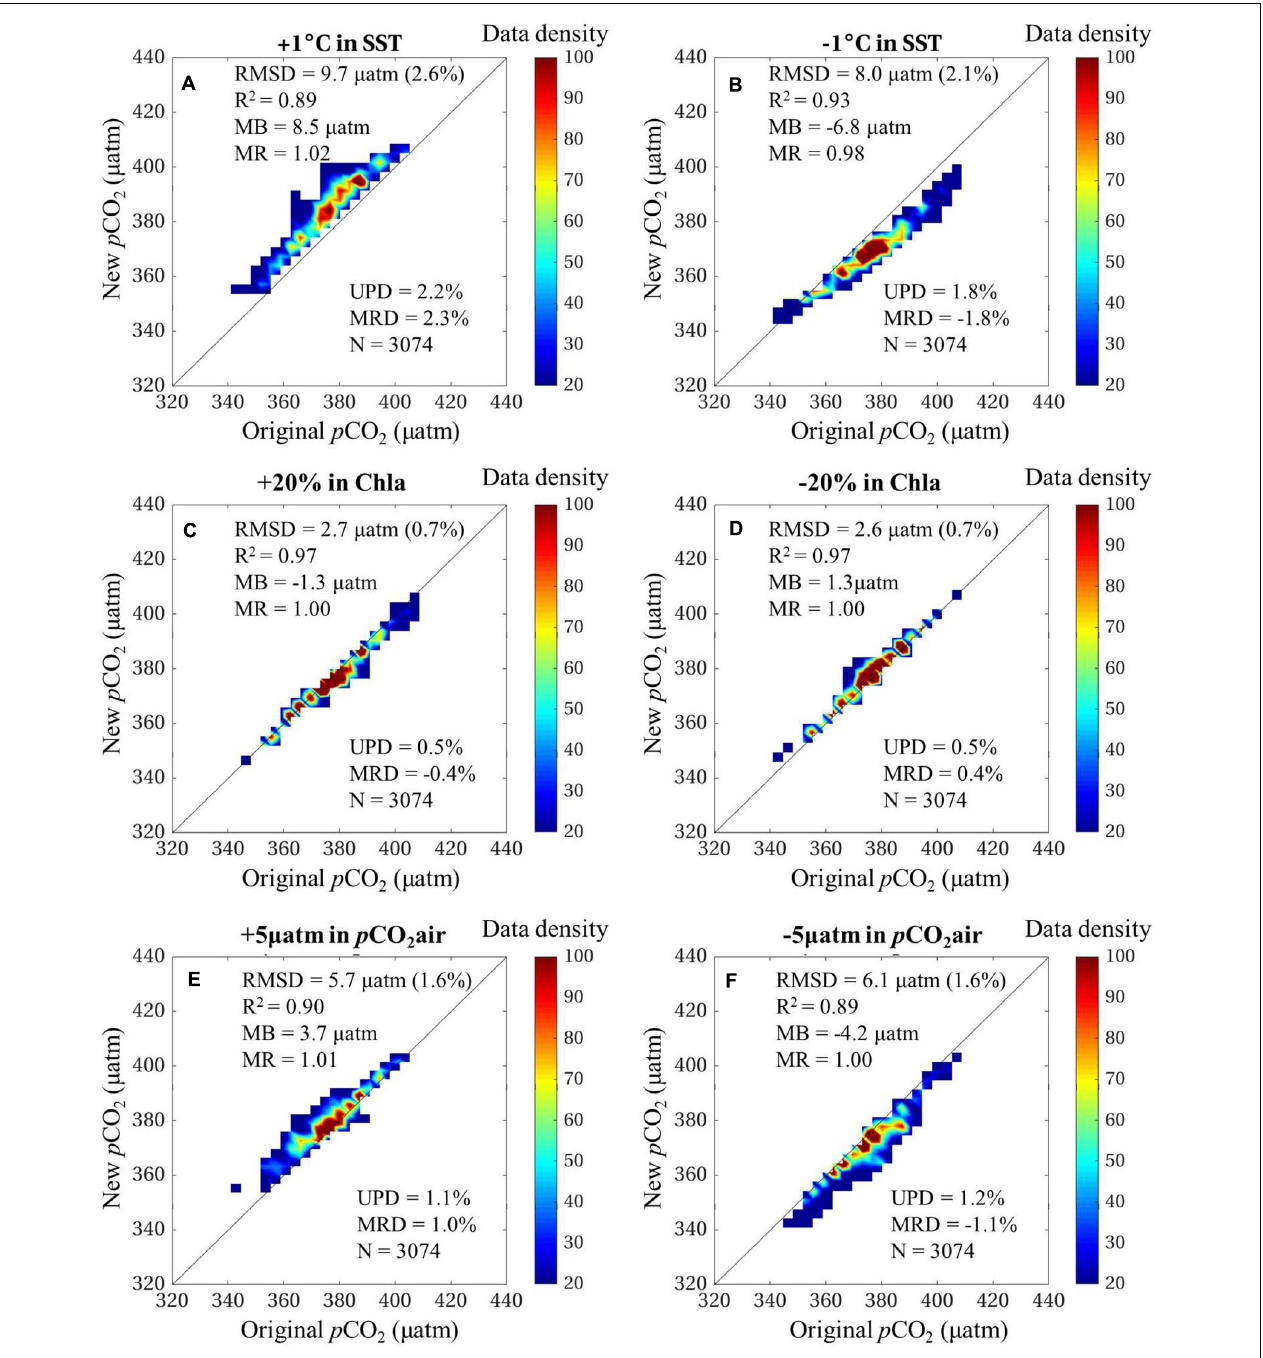
FIGURE 5 | Sensitivity of the RFRE p CO 2 sw algorithm to uncertainties in satellite-derived SST (A,B) and Chla (C,D) and to the natural variability of p CO 2 air (E,F) .